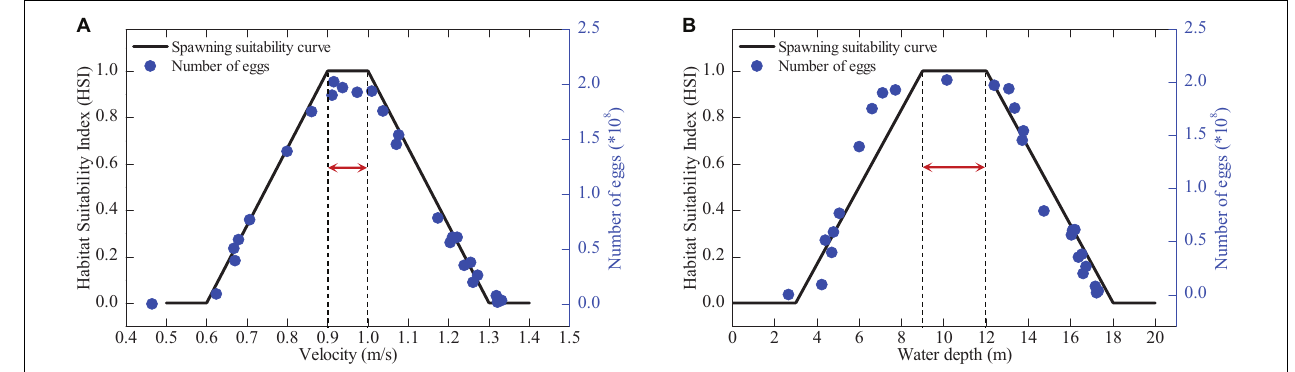
FIGURE 6 | Habitat suitability indexes (HSIs) and numbers of eggs for four major Chinese carp species (arrows indicate the optimal HSI range). (A) Velocity. (B) Water